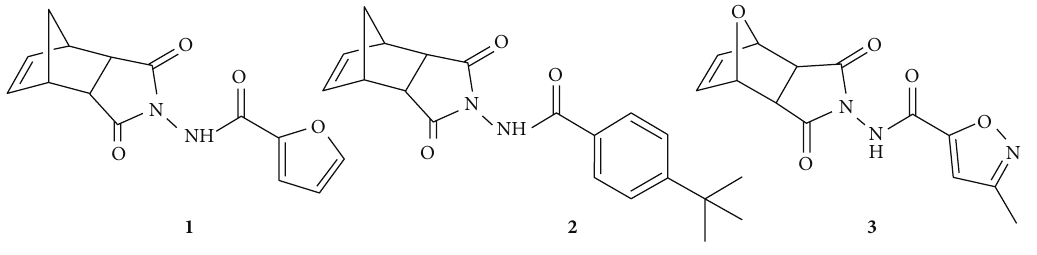
Figure 2: Synthesis of tricyclic imides, 1 , 2 , and 3 .